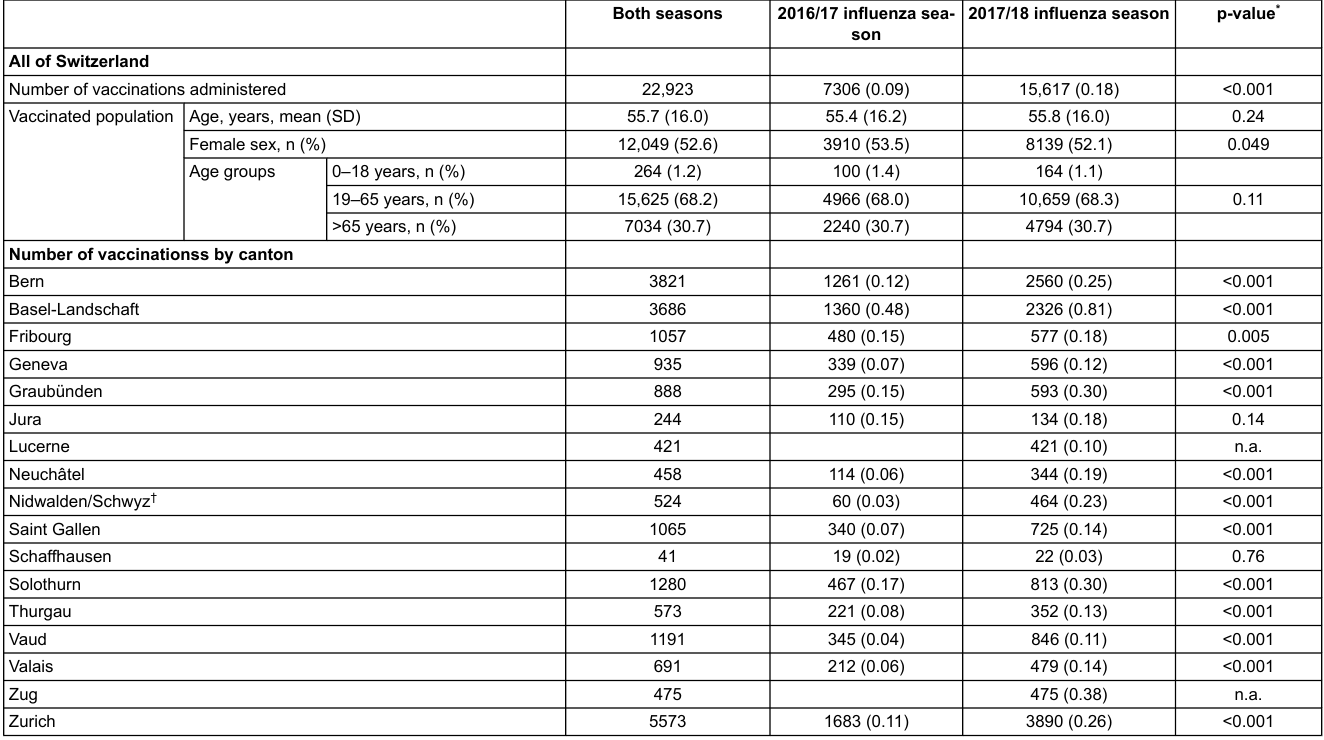
Table 4: Vaccinations in pharmacies authorised to vaccinate in the 2016/17 and 2017/18 influenza seasons.